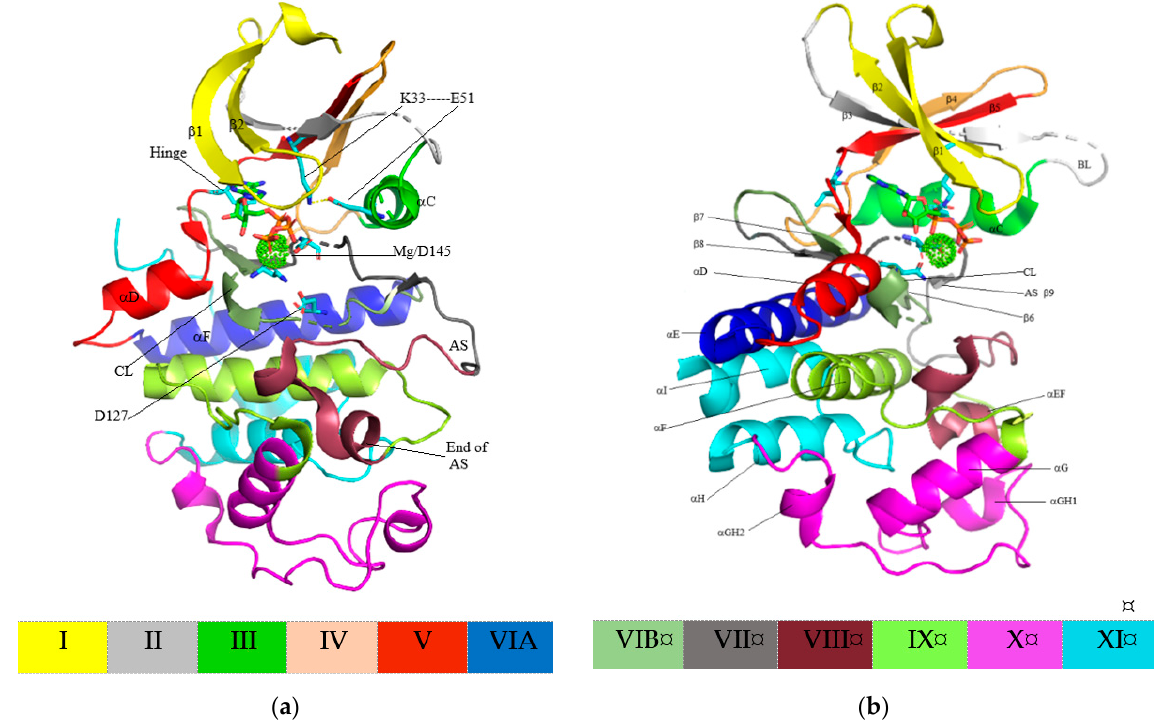
Figure 2. ( a ) Structure of the active CDK2 and ( b ) secondary structure of CDK2 (PDB ID 4EOQ). ATPs are shown in stick format, while Mg 2+ ions are illustrated as spherical dots. AS: activation segment; BL: back loop; CL: catalytic loop. The twelve domains described by Hanks and Hunter [62] are indicated by the color.